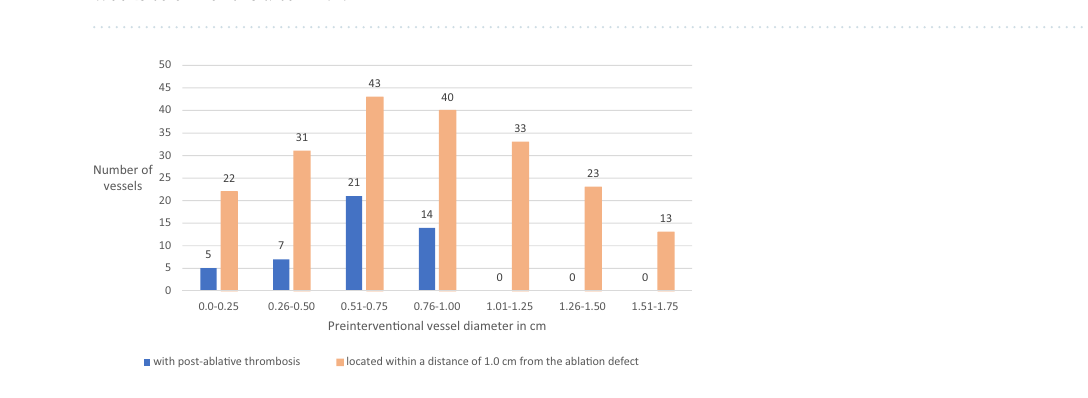
Figure 1. Distribution of post-ablative thrombosis relative to vessel diameter.